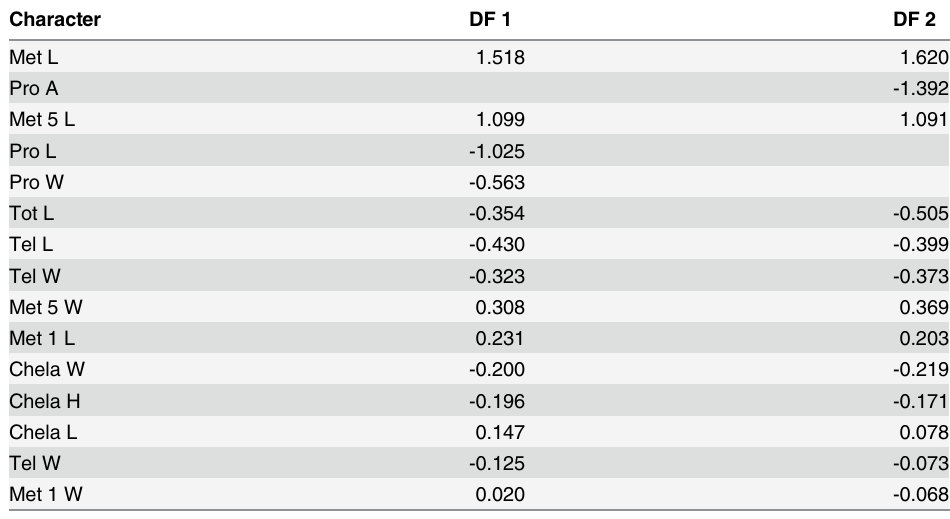
Squared structure coefficients indicated that the function accounted for 12%, 7% and 1% of the variance in these characters, respectively. Signs for the function coefficients indicated that the dif- ference between the sexes could largely be explained by the difference between metasoma length (represented by Met L and Met 5 L) and prosoma length, with males characterized by a longer Table 2. Standardized canonical coefficients of morphological characters of Hadrurus arizonenesis from two separate discriminant function analyses